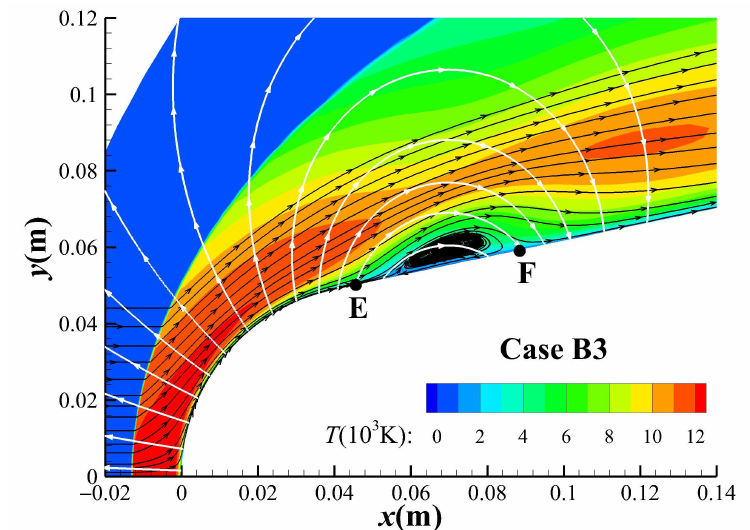
Figure 19. Temperature distribution of Case B3.